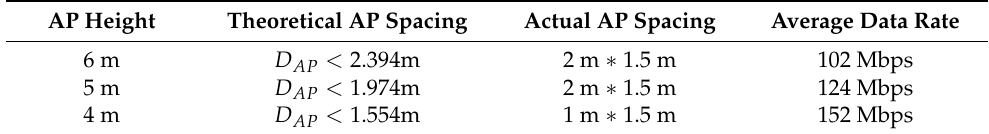
Table 5. AP placement without link interruption.